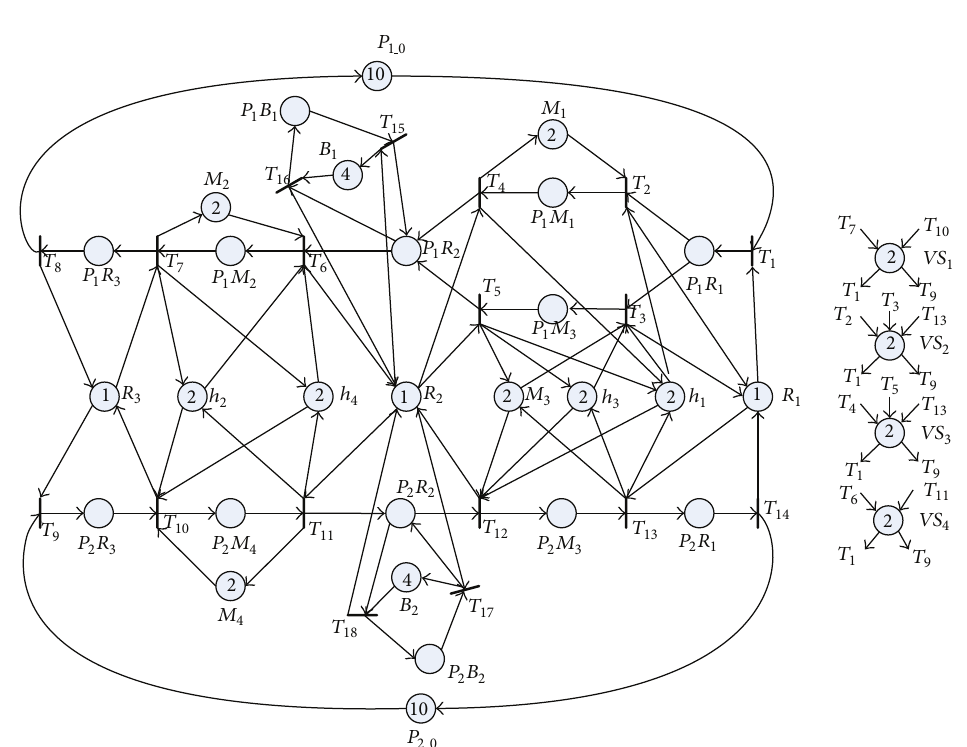
Figure 6: A controlled S ∗ PR Net of Figure